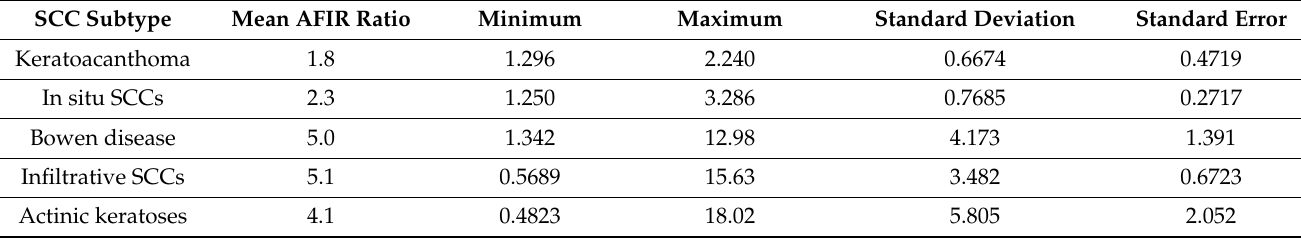
Table 2. Mean AFIR among different SCC